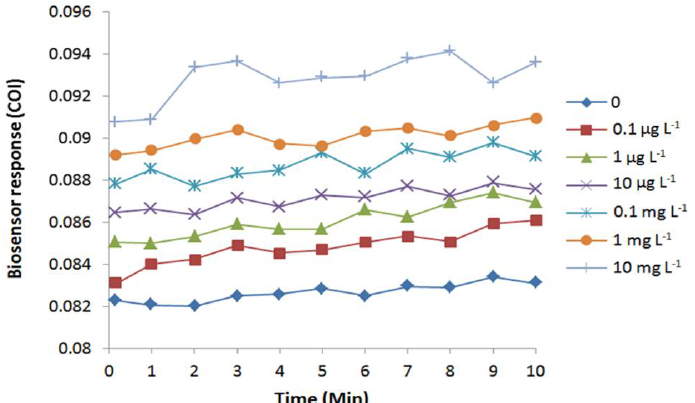
Figure 4. Cellular oxidation profile of E. coli roGFP2 oxidative stress biosensor exposed to NaAsO 3 (0.1 µg·L −1 –100 mg·L −1 ). A typical result out of 4 replicates is